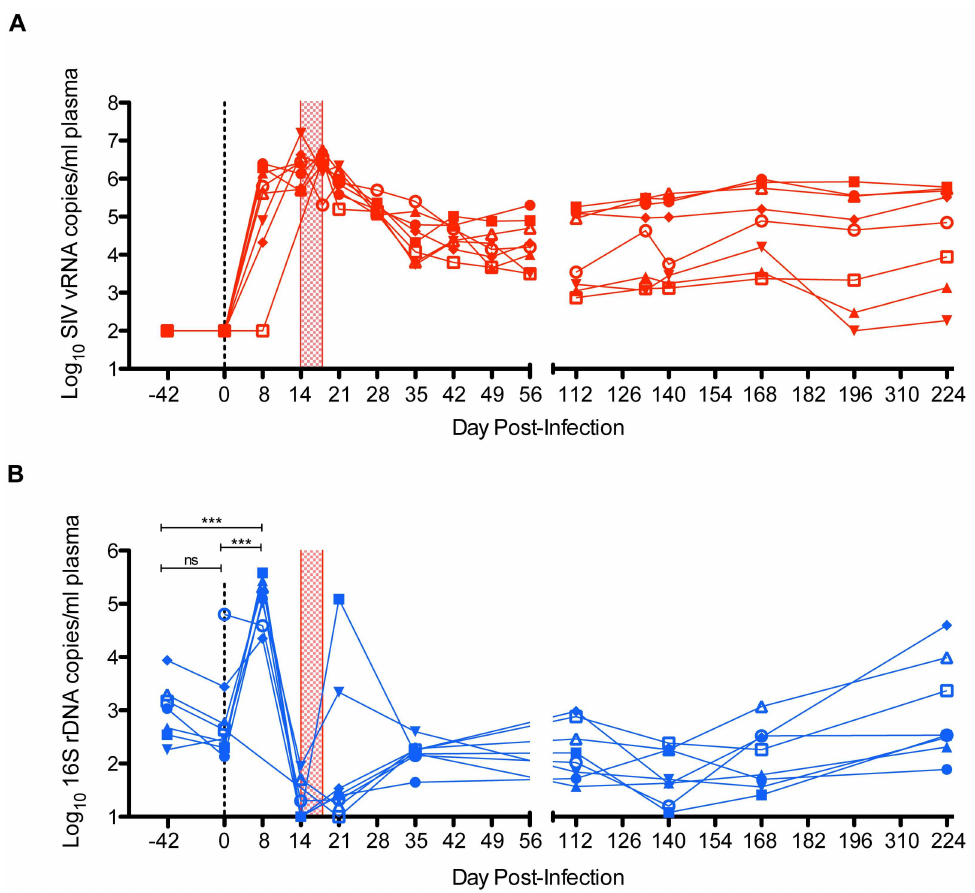
Fig 1. Longitudinal levels of SIV RNA and bacterial rDNA in plasma. Eight MHC-identical cynomolgus macaquesbecame infected followingintrarectal inoculationwith SIVmac239. ( A ) The number of SIV RNA copies/ml of plasma was enumerated using qRT-PCR. Values are Log 10 -transformed and plotted longitudinally. ( B ) 16S sequencing data was used to correct raw 16S rDNA qPCR data by removingthe proportionof 16S rDNA copies that correspondedto taxa detected in matched water controls. Corrected 16S rDNA copy data was Log 10 - transformed and plotted longitudinally. By Bonferroni-corrected one-wayANOVA, plasma levels of 16S rDNA did not change significantly between-42 and 0 DPI. Plasma levels of 16S rDNA increasedsignificantly(P < 0.0005) from both -42 to 8 DPI and 0 to 8 DPI. In both plots, the vertical checkeredbox positioned between14 and 18 DPI correspondsto the acute-phase peak of SIV replicationas detected by our